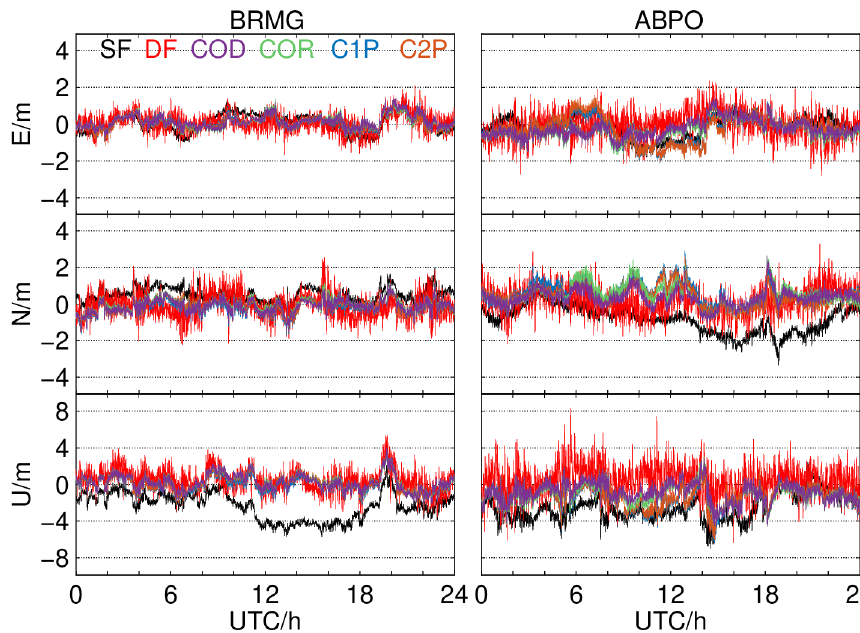
Figure 15. SPP positioning accuracy of different ionospheric products for BRMG and ABPO tracking stations.